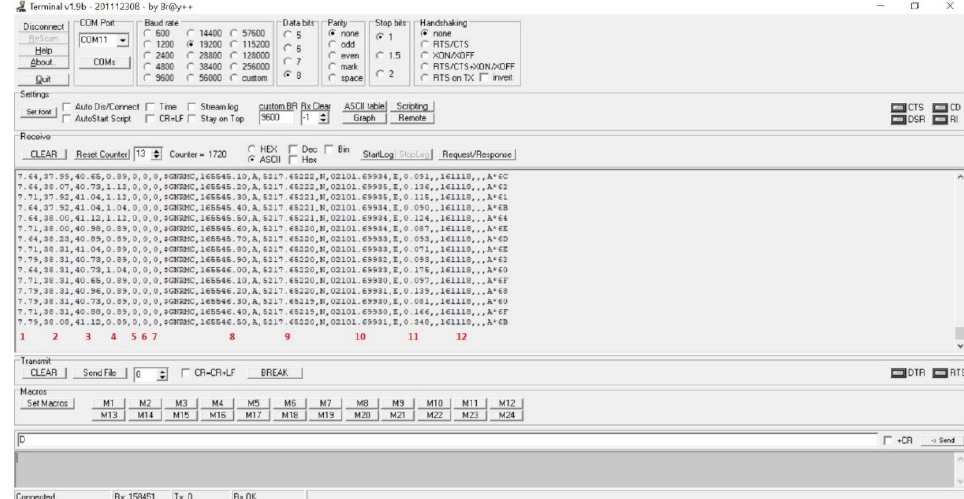
Figure 9. Measurement data frames.